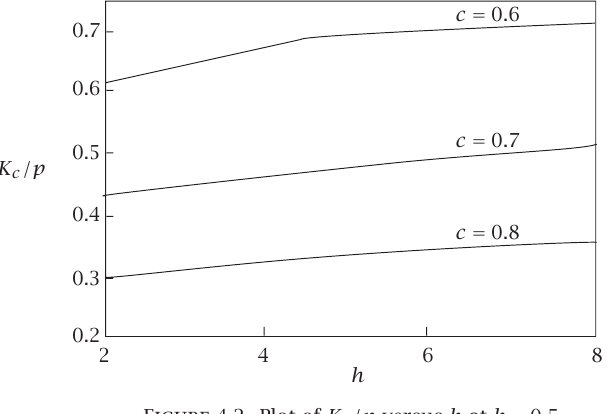
Figure 4.1 . Plot of K